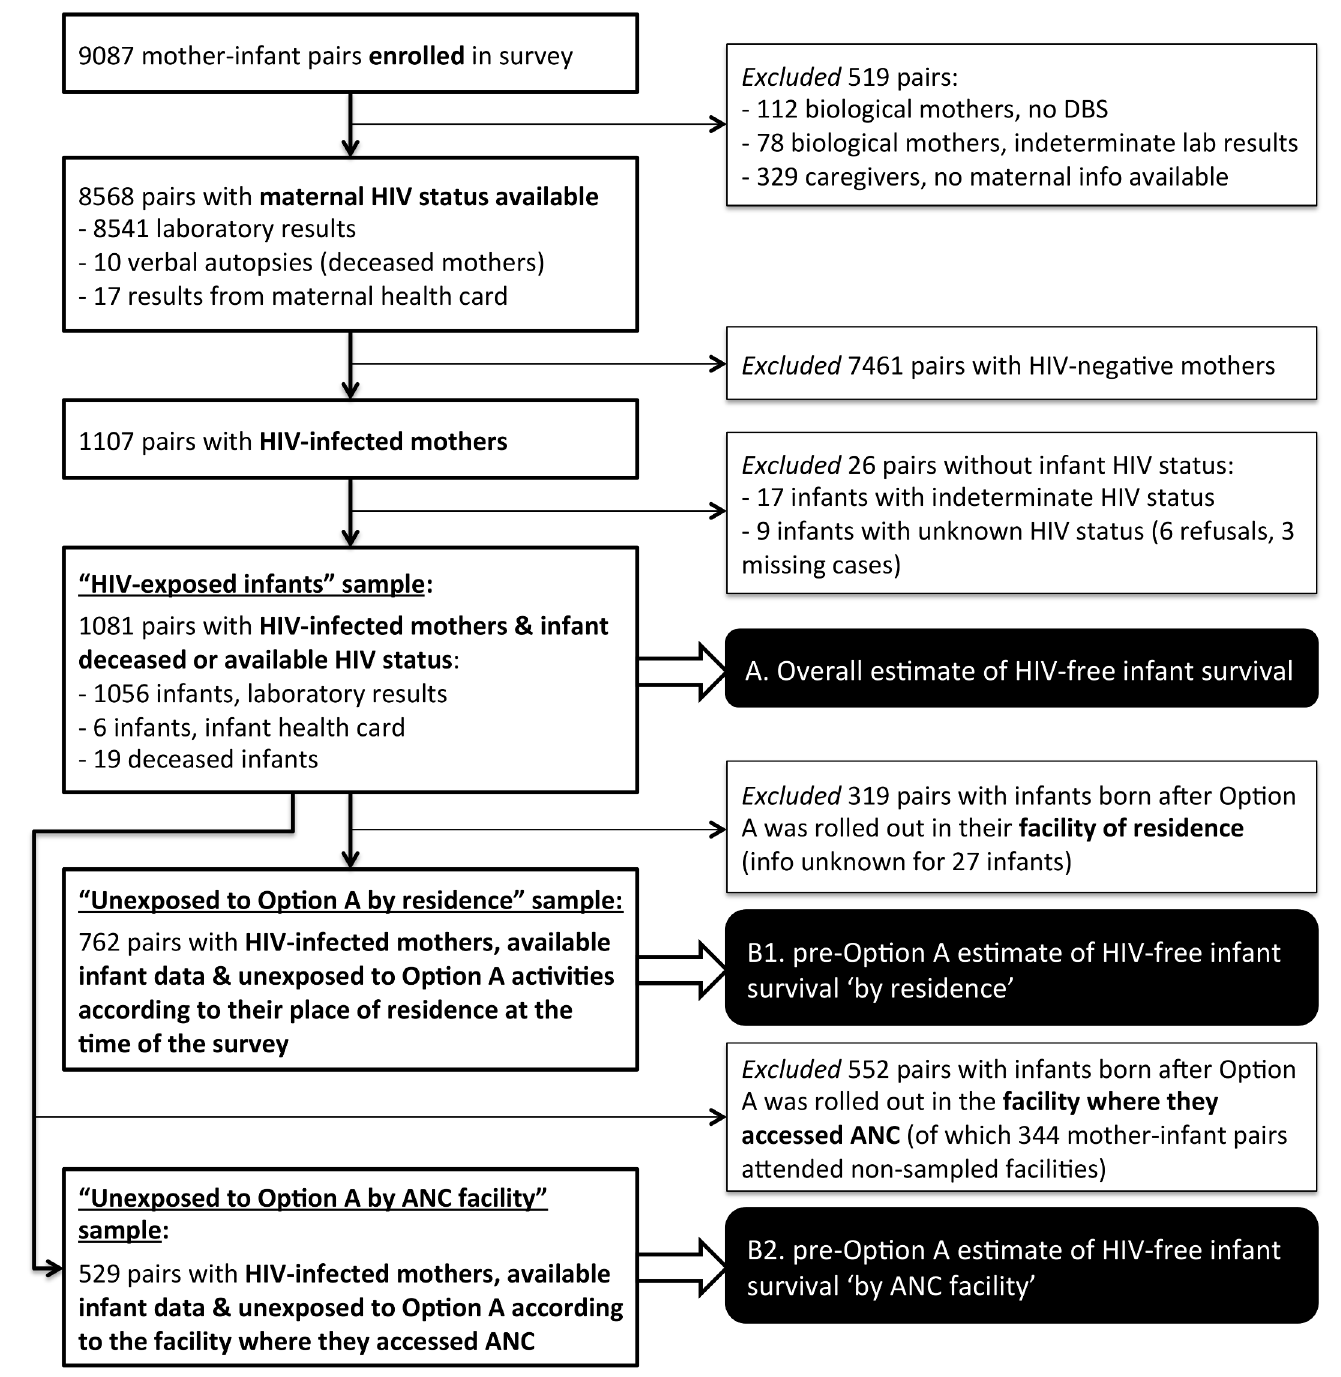
Fig 2. Samples of mother-infant pairs used to calculate three estimates of HIV-free infant survival at 9 – 18 months, Zimbabwe, 2012. The flowchart summarizes what samples were used to estimate HIV-free infant survival at 9 – 18 months. The overall estimate of HIV-free infant survival ( ‘ estimate A ’ ) was assessed among the ‘ HIV-exposed infants ’ sample (i.e., 1,081 pairs with HIV-infected mothers and infants either deceased or with available HIV status). The pre-Option A estimates of HIV-free infant survival ( ‘ estimates B1 and B2 ’ ) were assessed among subsets of the ‘ HIV-exposed infants ’ sample, after excluding the infants who were exposed to Option A activities. We measured exposure to Option A activities in two ways: 1) according to the facility closest to the infant ’ s residence at the time of the survey, and 2) according to the facility where antenatal care (ANC) was received. These pre-Option A samples of infants were used to assess HIV-free infant survival using two definitions of exposure: ‘ by residence ’ ( ‘ estimate B1 ’ ) and ‘ by ANC facility ’ ( ‘ estimate B2 ’ ).